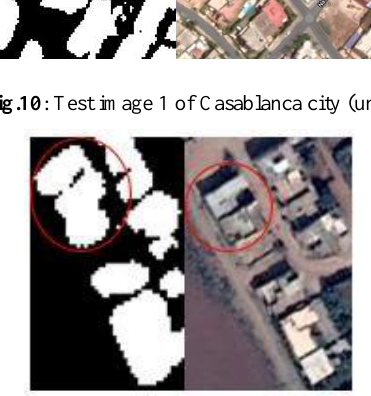
Fig.9: Original U-net for biomedical image segmentation.